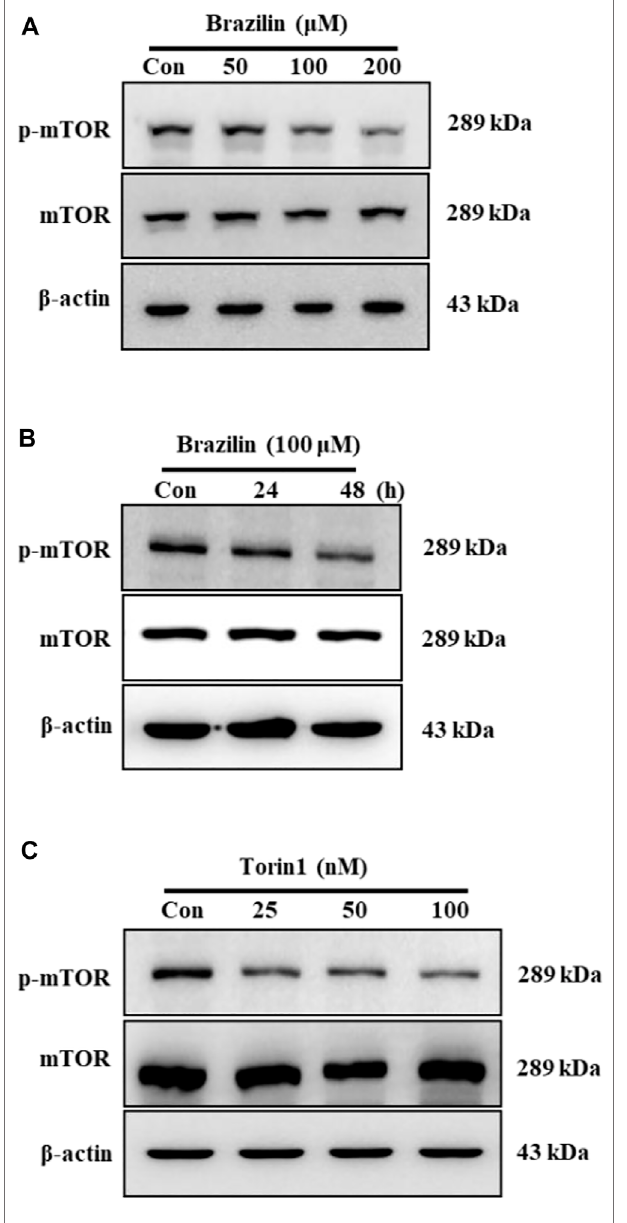
FIGURE 2 | Effects of brazilin on mTOR phosphorylation in colorectal cancer SW480 cells. SW480 cells were treated with different concentrations of brazilin for 48 h (A) and for indicated times with 100 μ M brazilin (B) . (C) SW480 cellswere treatedwithvarious concentrationsofTorin1 for48 h. Whole cell lysates were prepared, and phospho-mTOR was detected using Western blot analysis with anti-phospho-mTOR. The experiments were repeated for at least of three times.